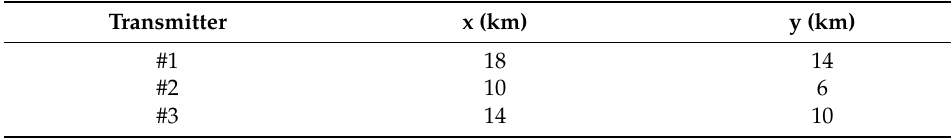
Table 7. Transmitting antennas positions.